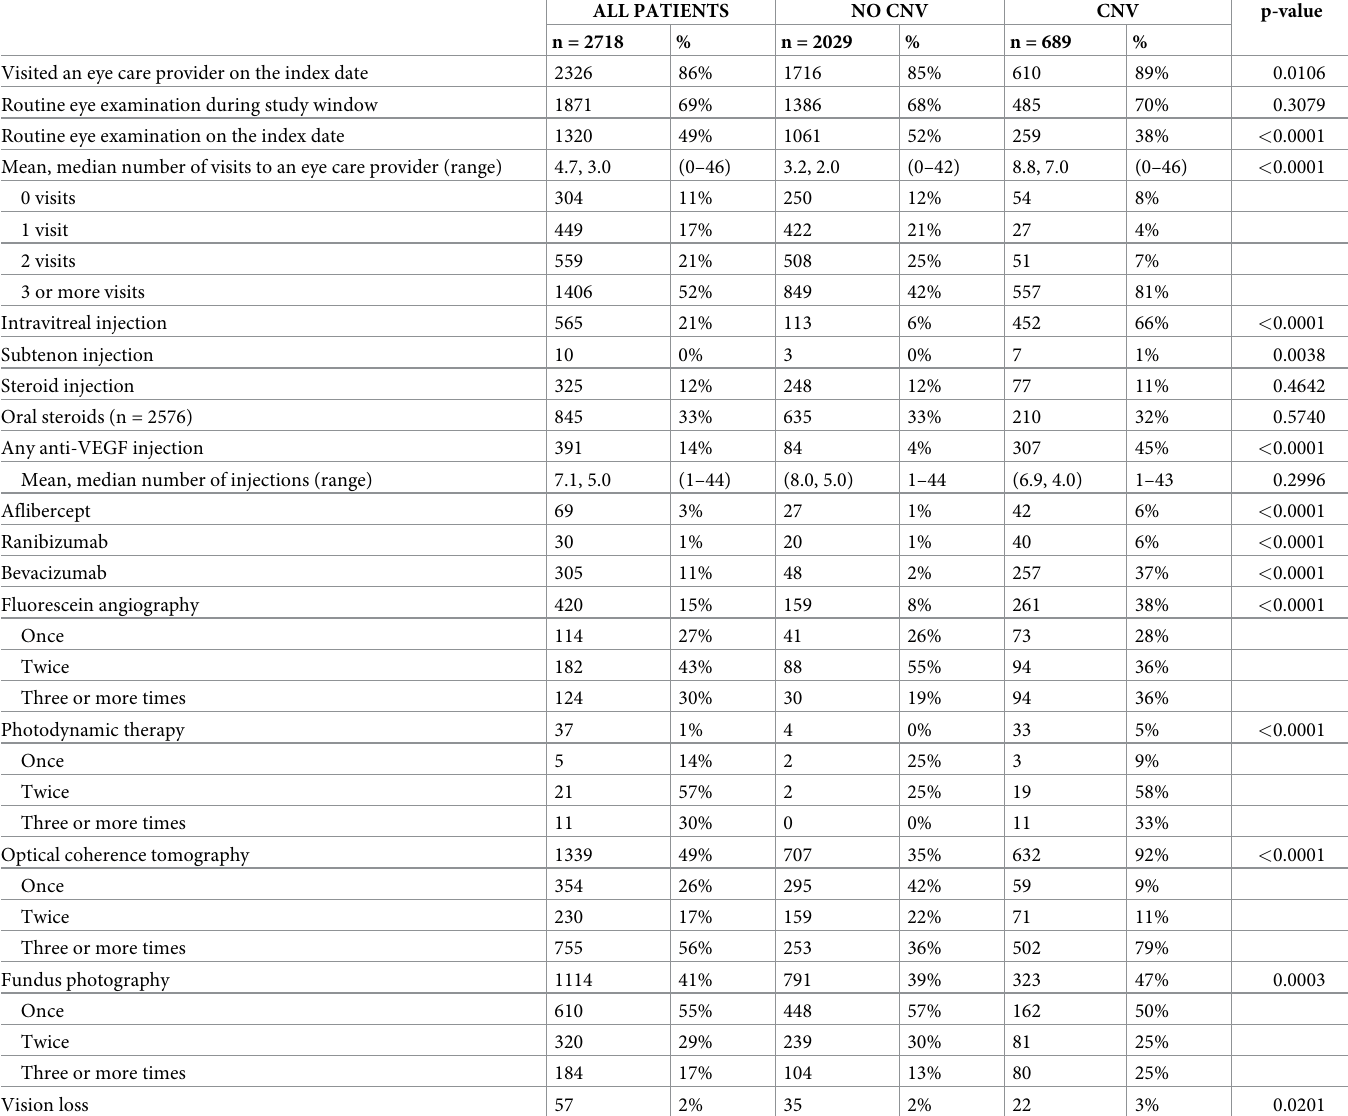
Table 2. Diagnosis, treatment, and outcomes among patients with presumed ocular histoplasmosis syndrome,